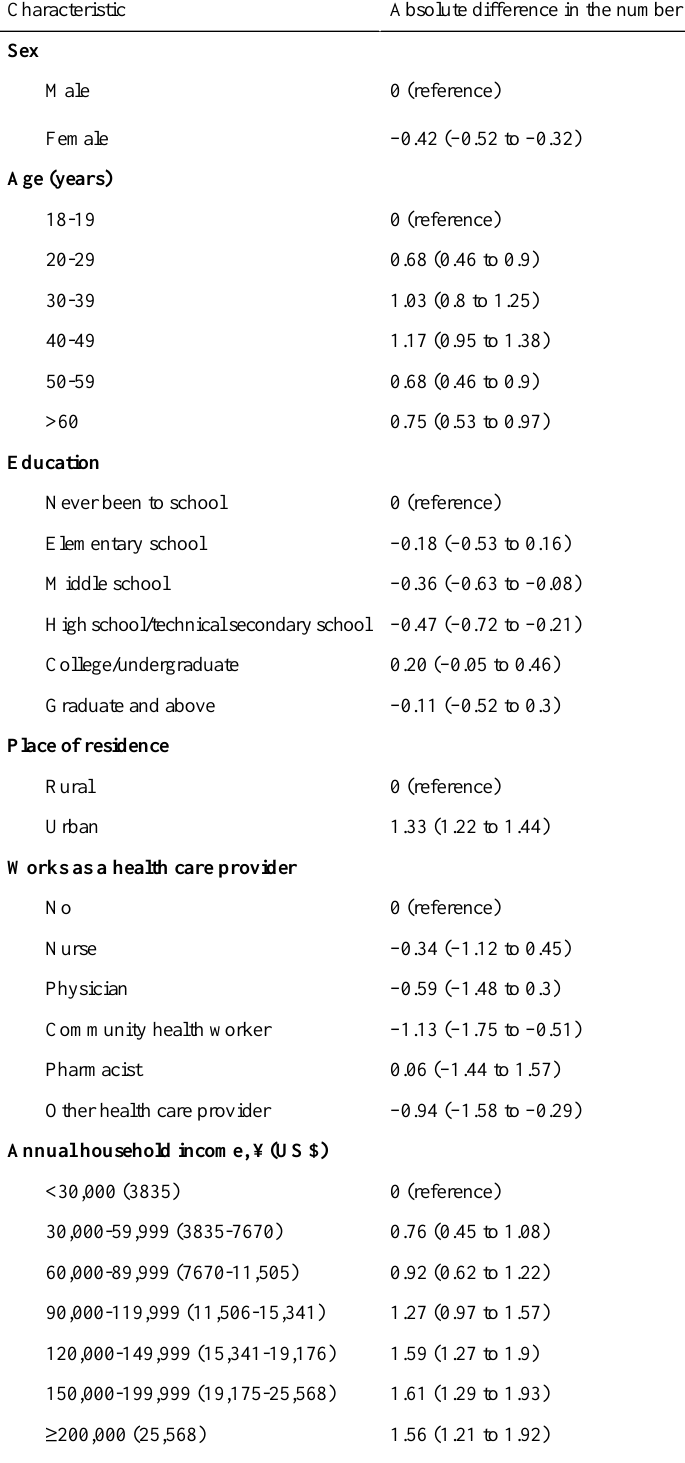
Table 3. Variation in the overall knowledge score by sociodemographic characteristics.